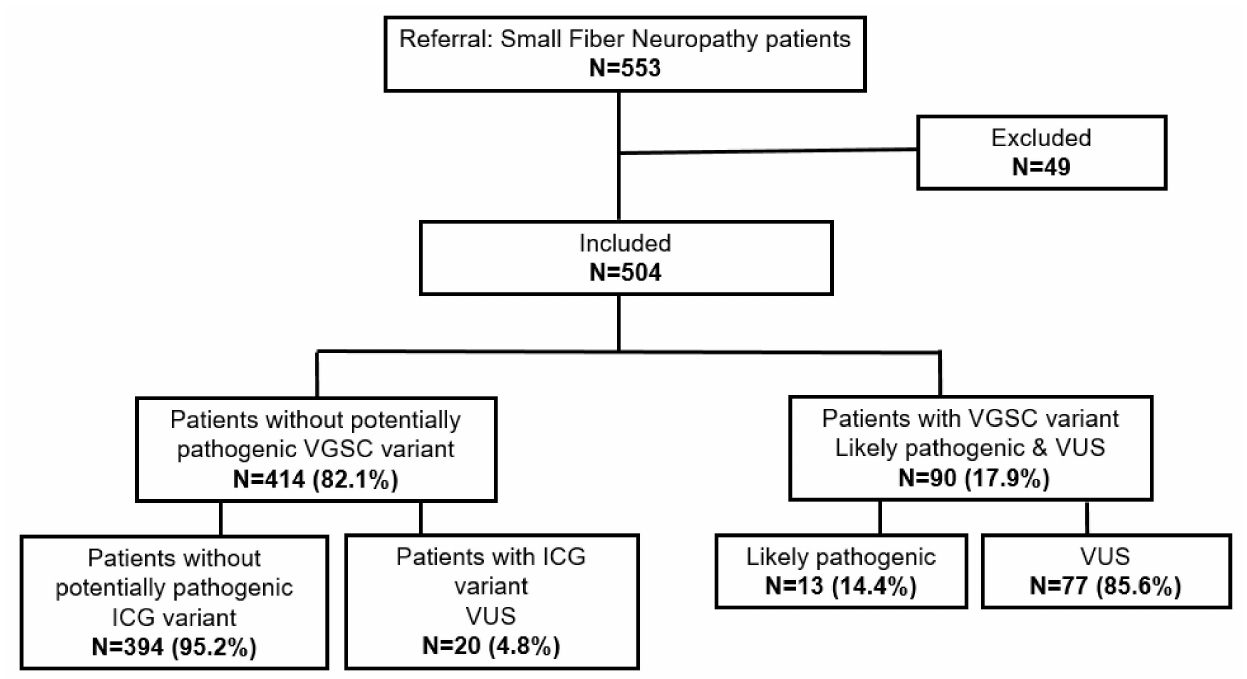
Figure 1. SFN patients analyzed using smMIP-NGS for (potentially) pathogenic ICG and VGSC variants. ICG, ion channel gene; VGSC, voltage-gated sodium ion channel; VUS, variant with uncertain clinical